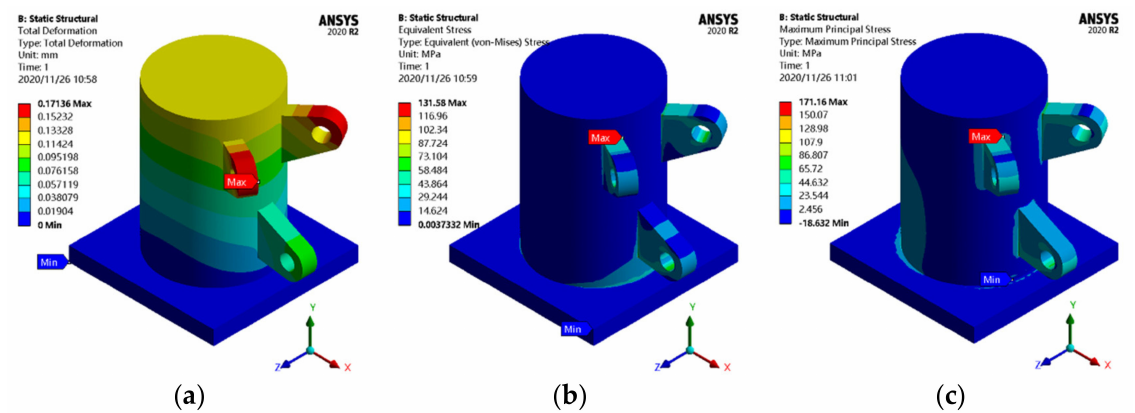
Figure 5. Static analysis results of the initial joint: ( a ) displacement cloud map; ( b ) equivalent stress cloud map; ( c ) principal stress cloud